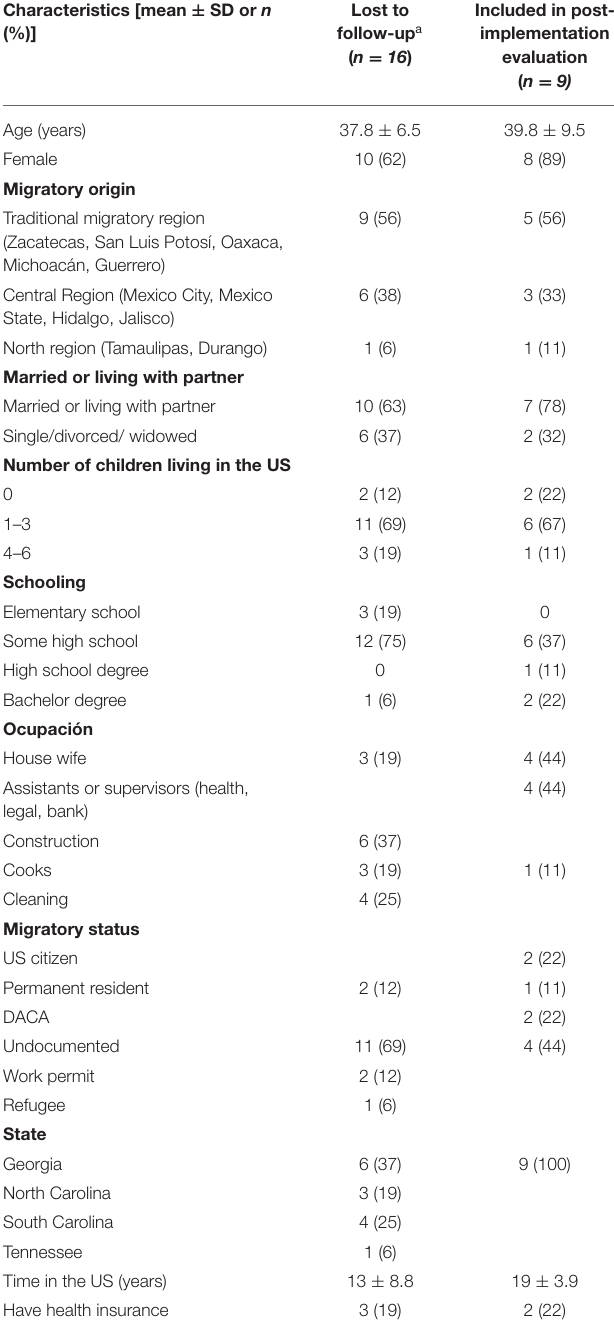
TABLE 1 | Sociodemographic characteristics of participants included ( n = 9) and excluded ( n = 16) from the pre-post evaluation. Characteristics [mean ± SD or n